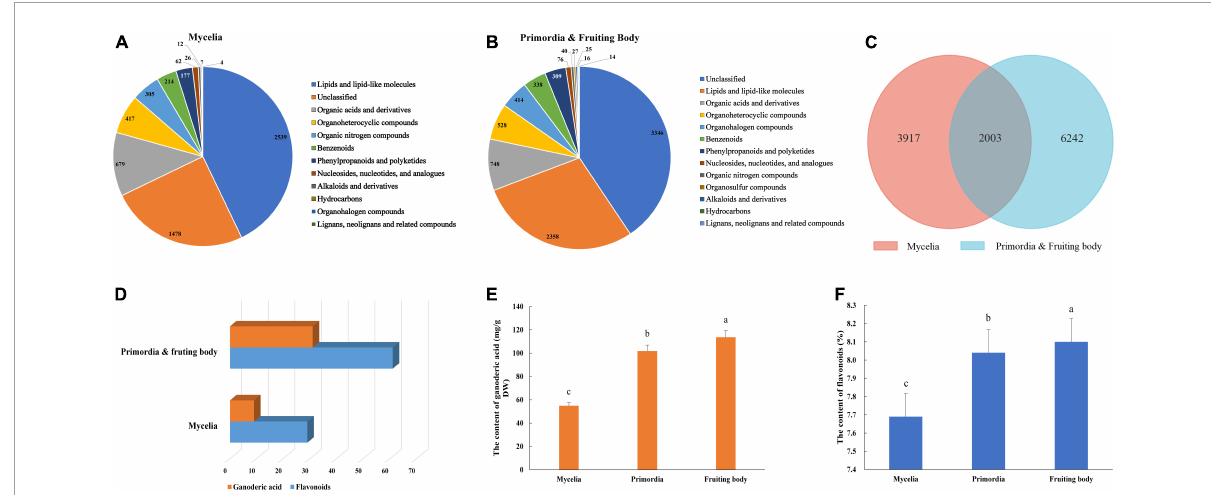
FIGURE2 Metabolite identification in the development of G. lucidum . Panels (A,B) are the kinds of metabolites in the Mycelia, and Primordia and Fruiting body. Panel (C) the is Venn diagram of common metabolites in the Mycelia and Primordia and Fruiting body. Panels (D–F) are the kinds of secondary metabolites, contents of GAs and flavonoids. Means within a column carrying the same letter are not significantly different. Different superscript lowercase letters (a, b, and c) indicate significant differences ( p <